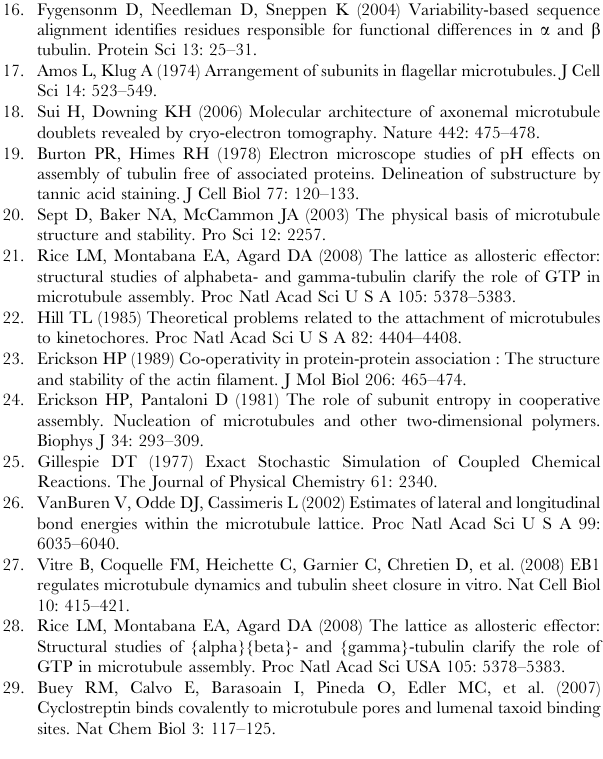
Figure S3 Schematic Illustration of the physical origins of the temperature dependence of the free energy terms. (a) D G Sh and D G changes sign over T. (b) The dependence of D G TuTu on the